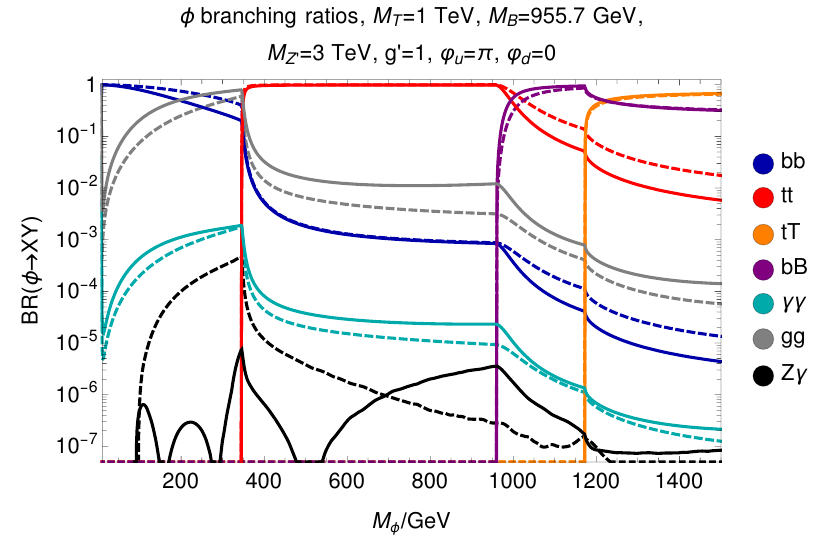
Figure 4. BRs of the Yukon φ as a function of M φ . Here, solid lines represent θ 34 dashed ones denote θ 34 = π/ 6 Q